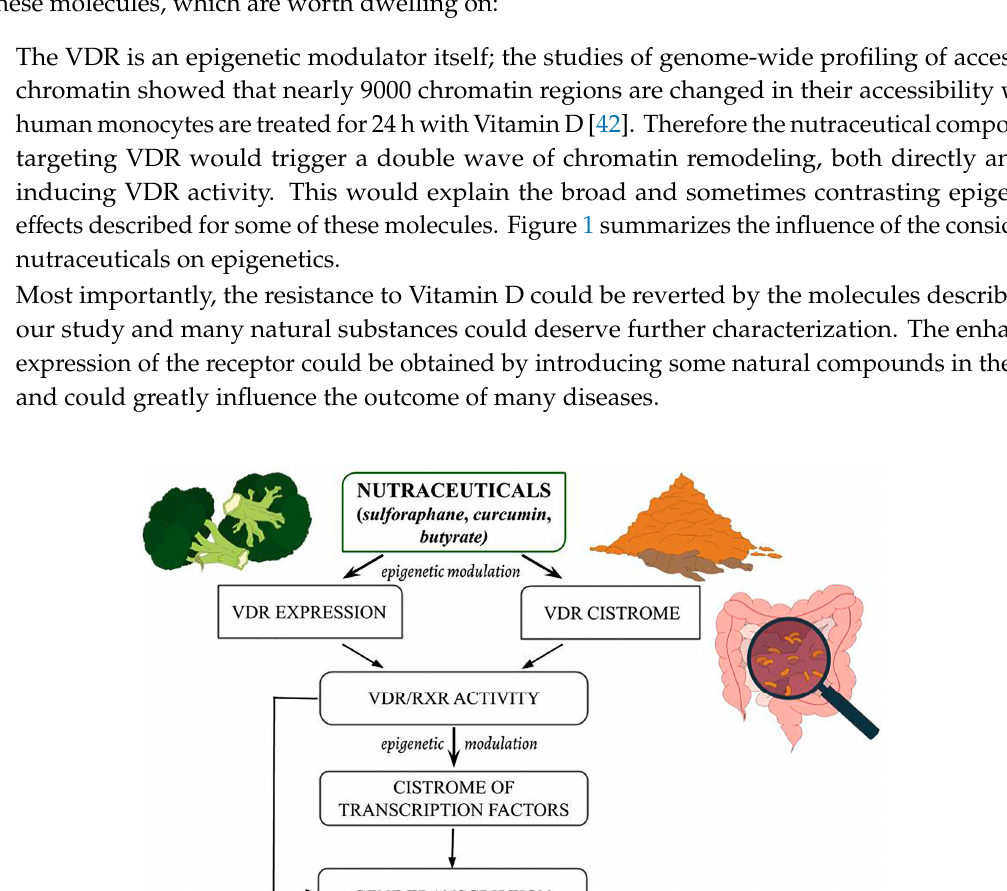
Table S1: Factors a ff ecting VDR